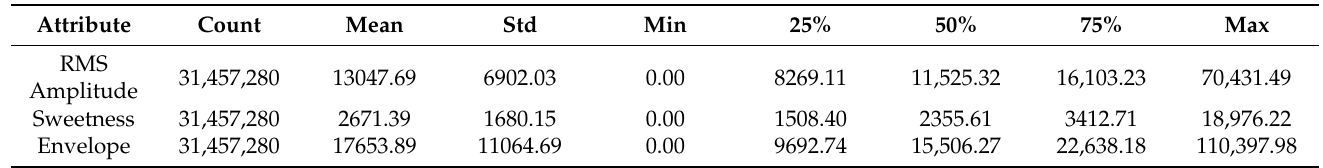
Table 6. The basic statistic information of seismic amplitude